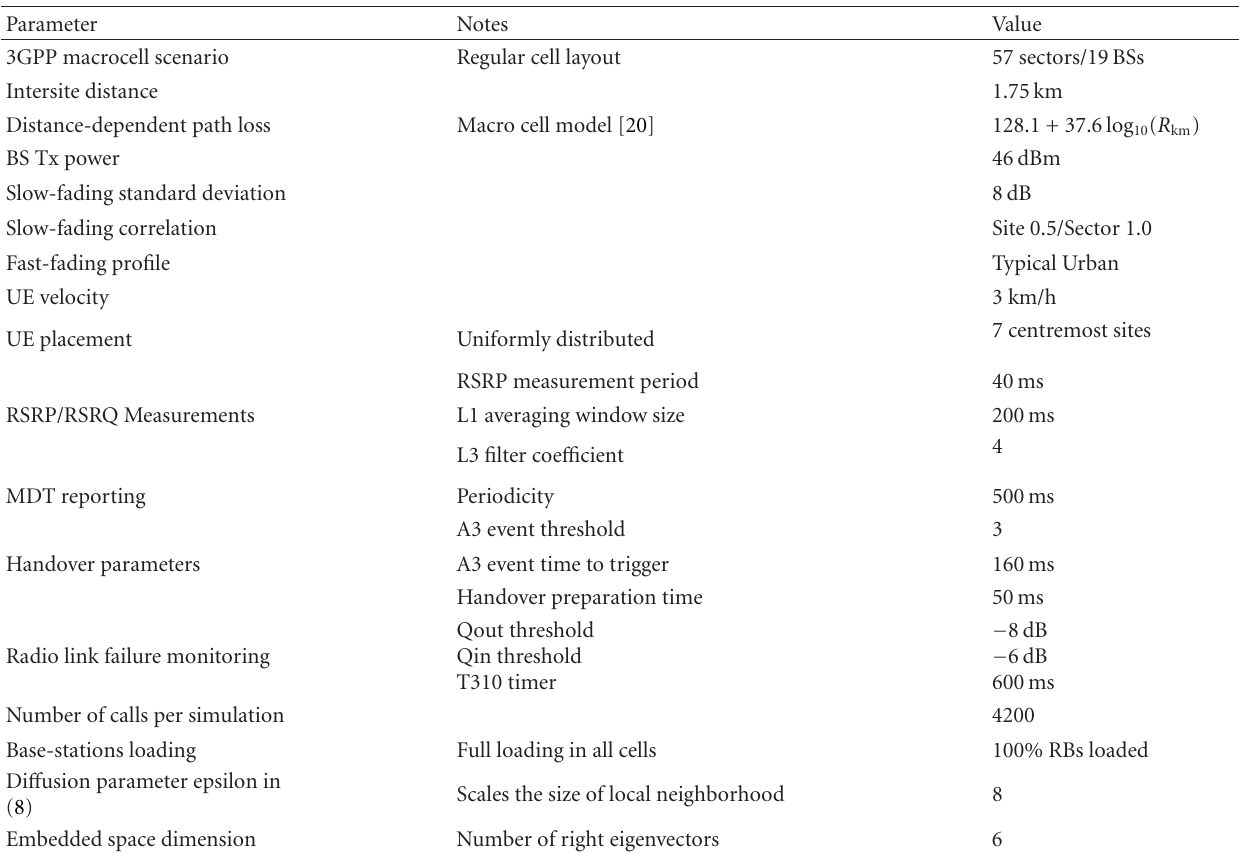
Table 4: Simulator